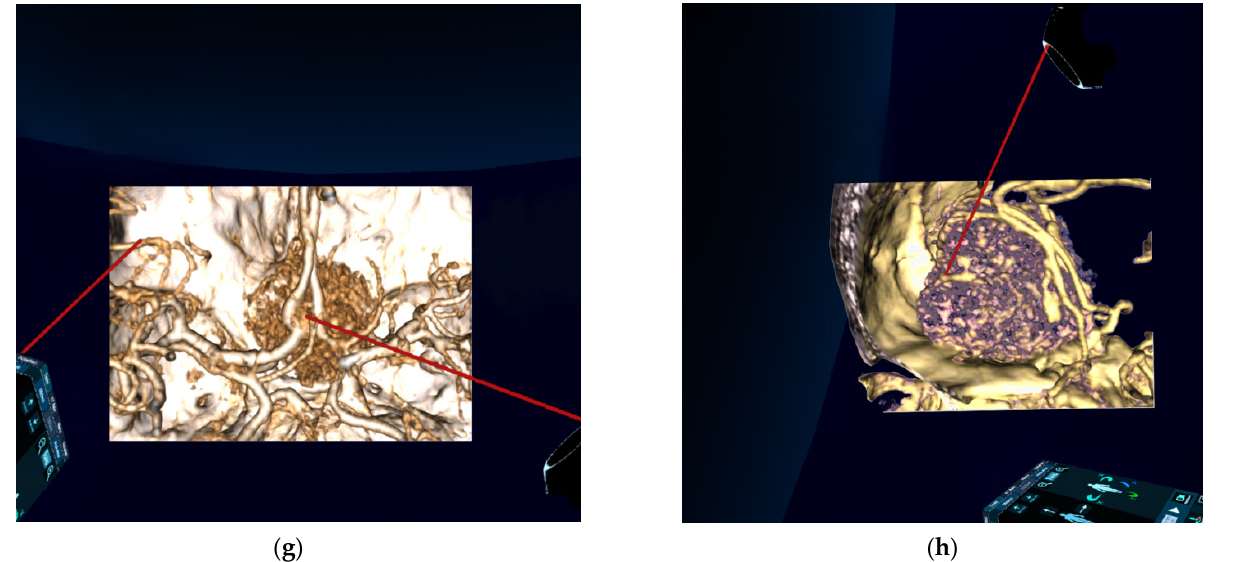
Figure 4. Preoperative reconstructed 3D-virtual reality images (reconstructed from 2D-CT and 2D-MRI) of patients with anterior skull base meningiomas. ( a ) Oblique lateral aspect showing olfactory groove meningioma. ( b ) Superior aspect showing frontobasal meningioma. ( c ) Superior aspect showing planum sphenoidale meningioma. ( d ) Lateral aspect showing anterior clinoidal meningioma. ( e ) Anterior aspect showing olfactory groove meningioma. ( f ) Highly zoomed superior aspect showing planum sphenoidale meningioma. ( g ) Zoomed superior aspect showing planum sphenoidale meningioma. ( h ) Zoomed oblique lateral aspect showing olfactory groove meningioma. 2D, two-dimensional; 3D, three-dimensional CT, computed tomography; MRI, magnetic resonance imaging.